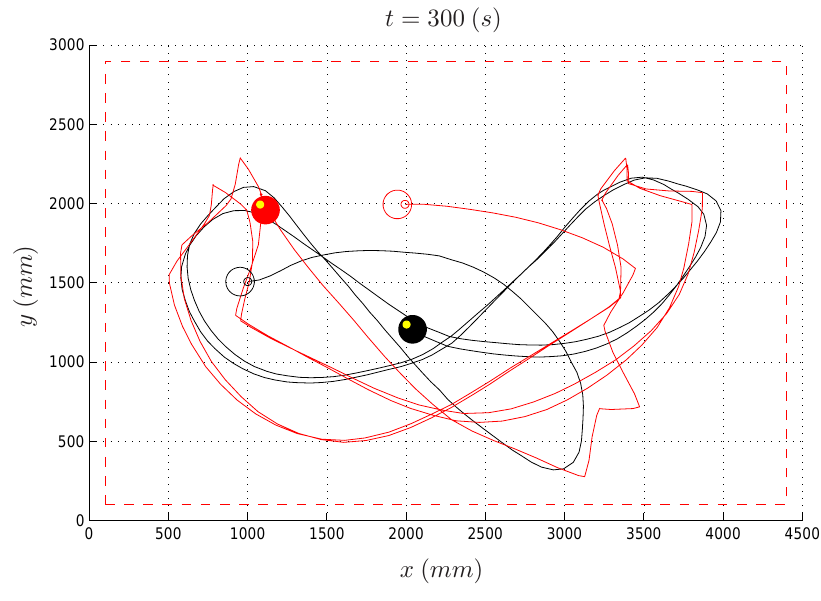
Figure 14. Pursuer-evader games, Algorithm 2: pursuer (black) and evader (red) with a PE speed ratio equal to 50%.